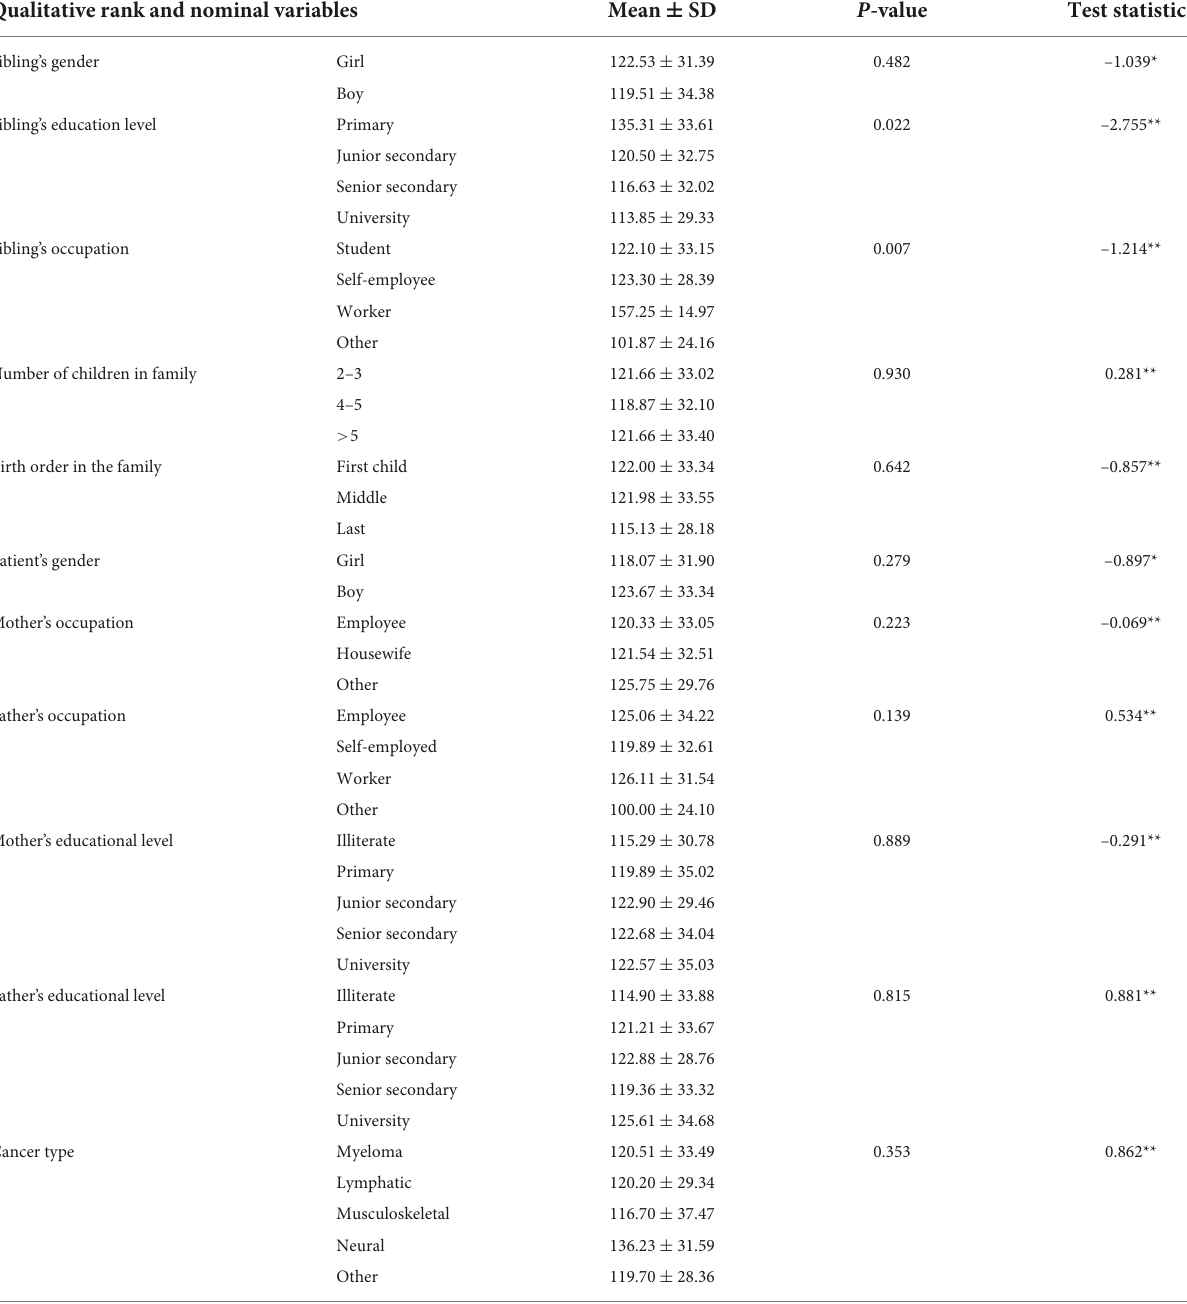
TABLE 4 Unfulfilled psychosocial needs according to demographic and clinical variables. Qualitative rank and nominal